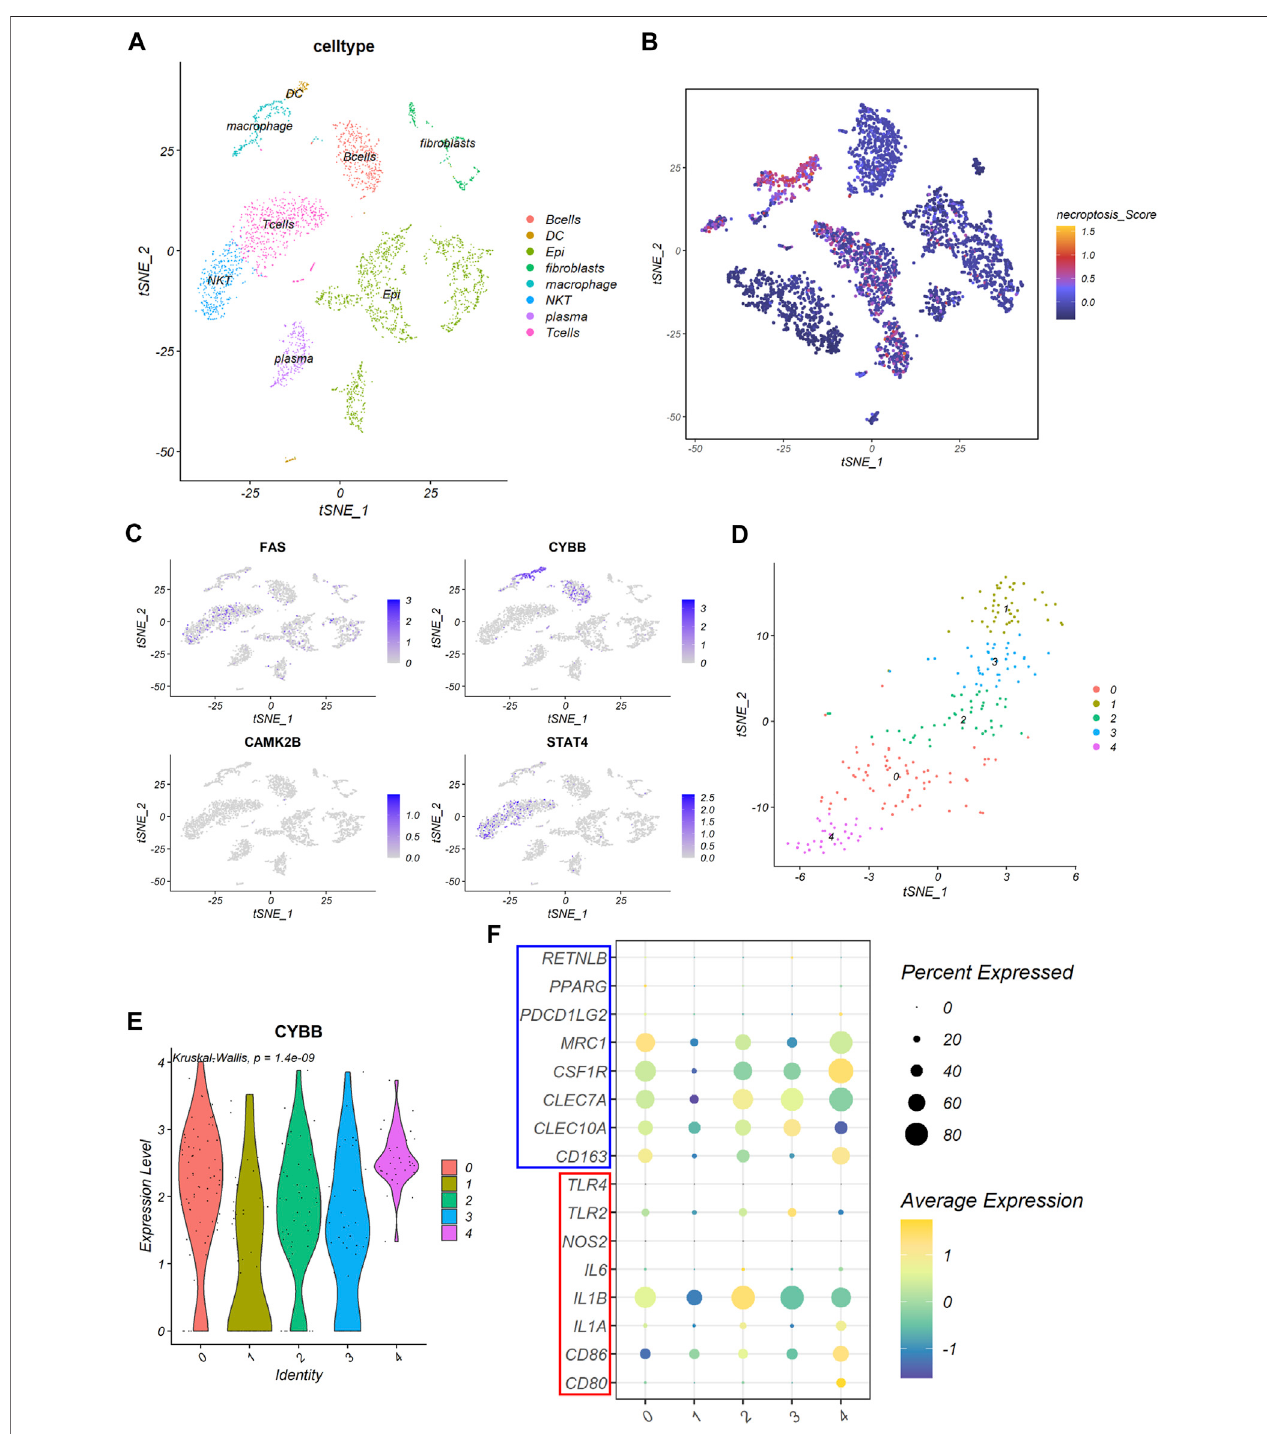
FIGURE 7 | The expression of the necroptosis signature in colon cancer. (A) The t-SNE plot shows percentage of eight cell types in colon cancer tissues. (B) The t-SNE plot shows necroptosis score of each cell cluster. (C) The t-SNE plots shows expression levels of FAS, CYBB, CAMK2B, and STAT4 in each cell cluster. (D) The t-SNE plotshows fi ve clustersofmacrophages, denoted by 0 – 4, identi fi edby the Rpackage Seurat. (E) Theviolin plot shows expression levels ofCYBB among the fi ve macrophage clusters. (F) The bubble plot shows expression of macrophage marker genes among the fi ve macrophage clusters. Gens in the red box are M1 macrophage marker genes and genes in the blue box are M2 macrophage marker genes.